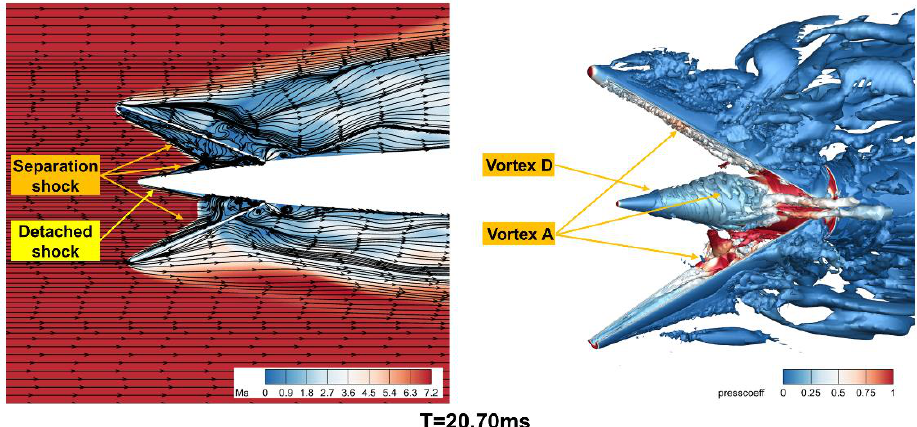
Figure 24. The contour of streamline and Mach number ( left ), and iso-surface of Q-criterion ( right ) at Time = 20.70 ms.